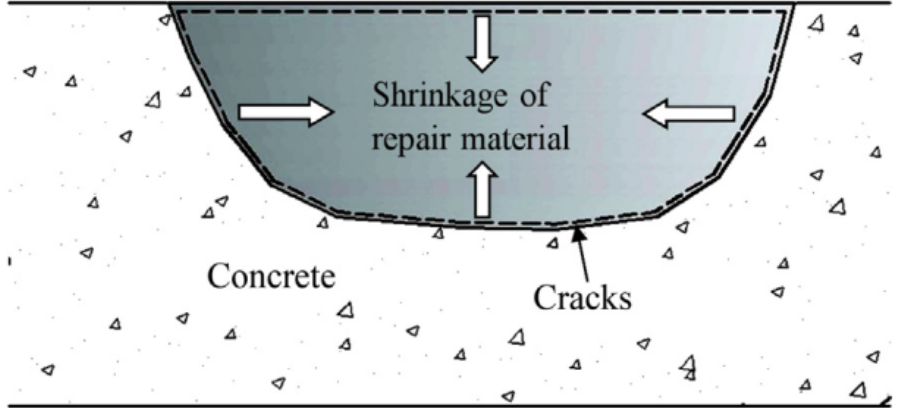
Figure 2. Schematic illustration of shrinkage of repair materials in patch repair [11]. (Adapted and reprinted with permission from ref. [11], © 2014, Construction and Building Materials .).